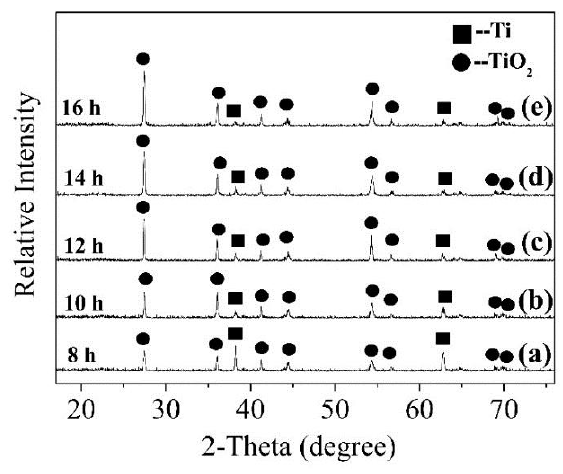
Figure 5. XRD patterns of samples prepared for different times. ( a ) 8 h; ( b ) 10 h; ( c ) 12 h; ( d ) 14 h; ( e ) 16 h.